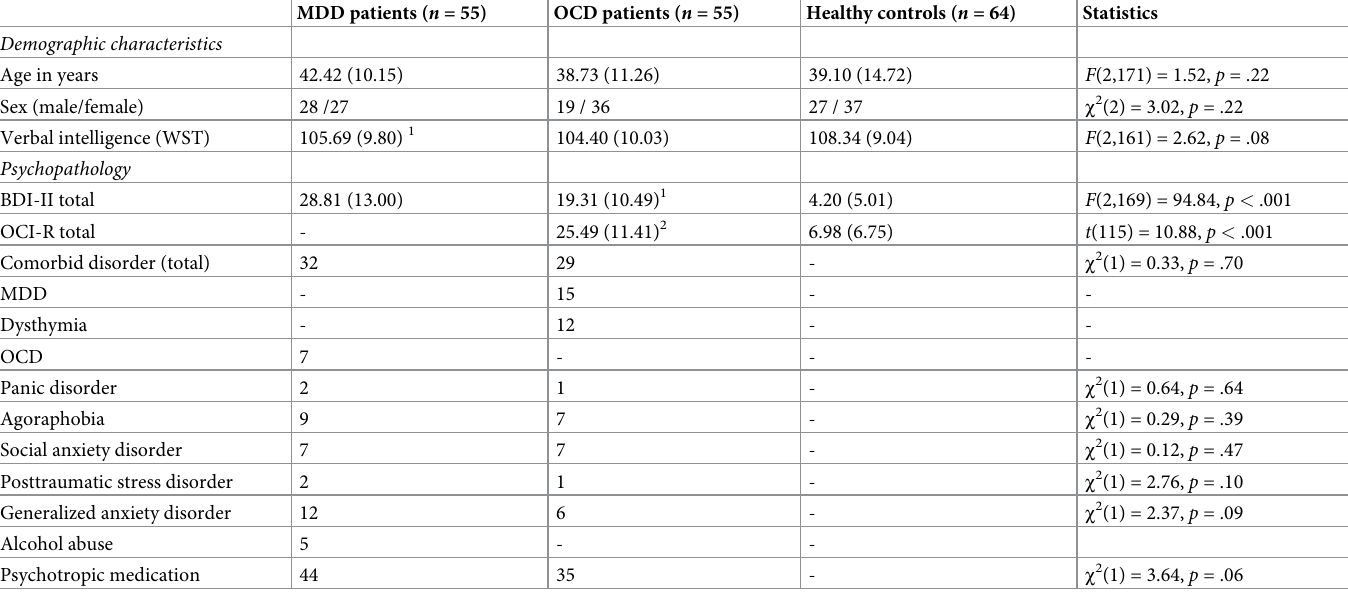
Table 1. Demographic and psychopathological data: Mean (standard